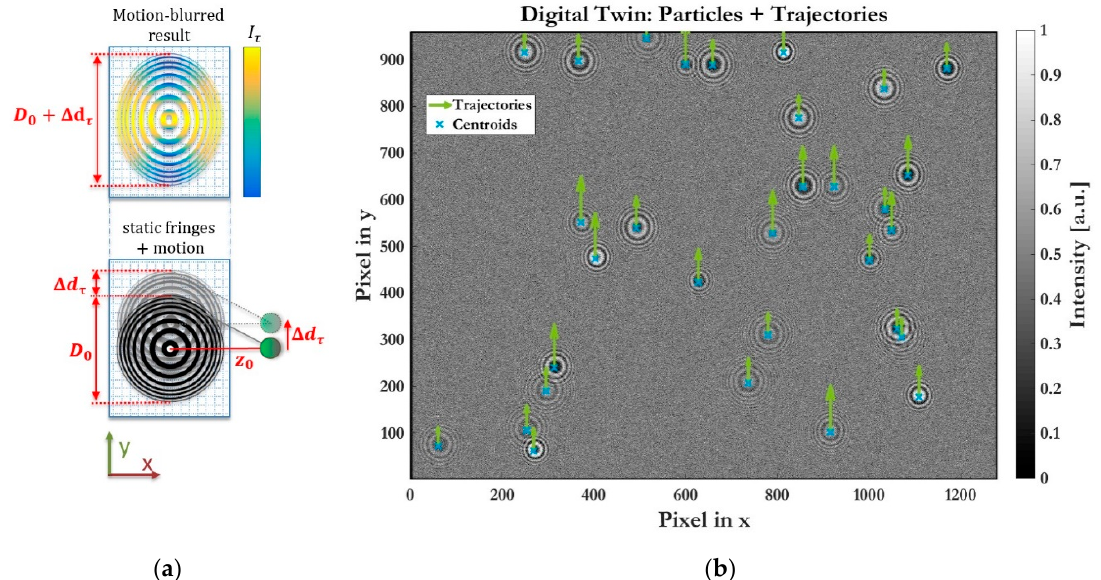
Figure 2. Aerosol particle model result: ( a ) scheme of motion-blurring in y -direction ( b ) 4.8 × 3.6 × 4 mm sampling volume of arbitrary particle density, with particle’s centroids and trajectories (with enhanced